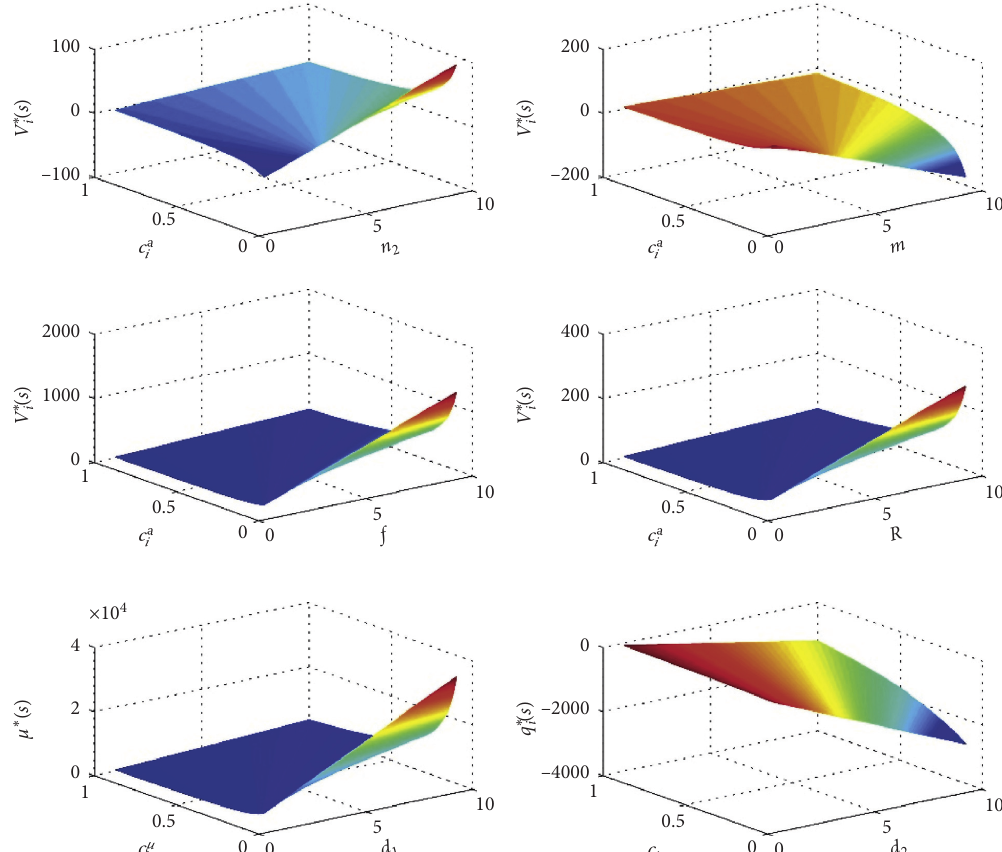
Figure 2: The relationship between the set of feedback strategies and the multiple factor